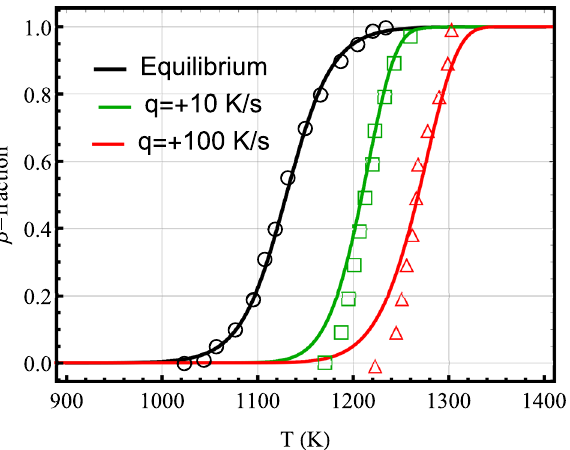
Figure 8. Volume fraction of β phase as a function of temperature calculated (lines) using model B versus measured data (markers) 11 for Zr1NbO at heating rates q equilibrium.